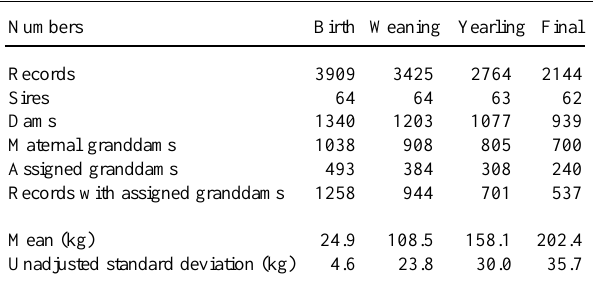
Table I - Characteristics of the data including weights of Gobra cattle at different